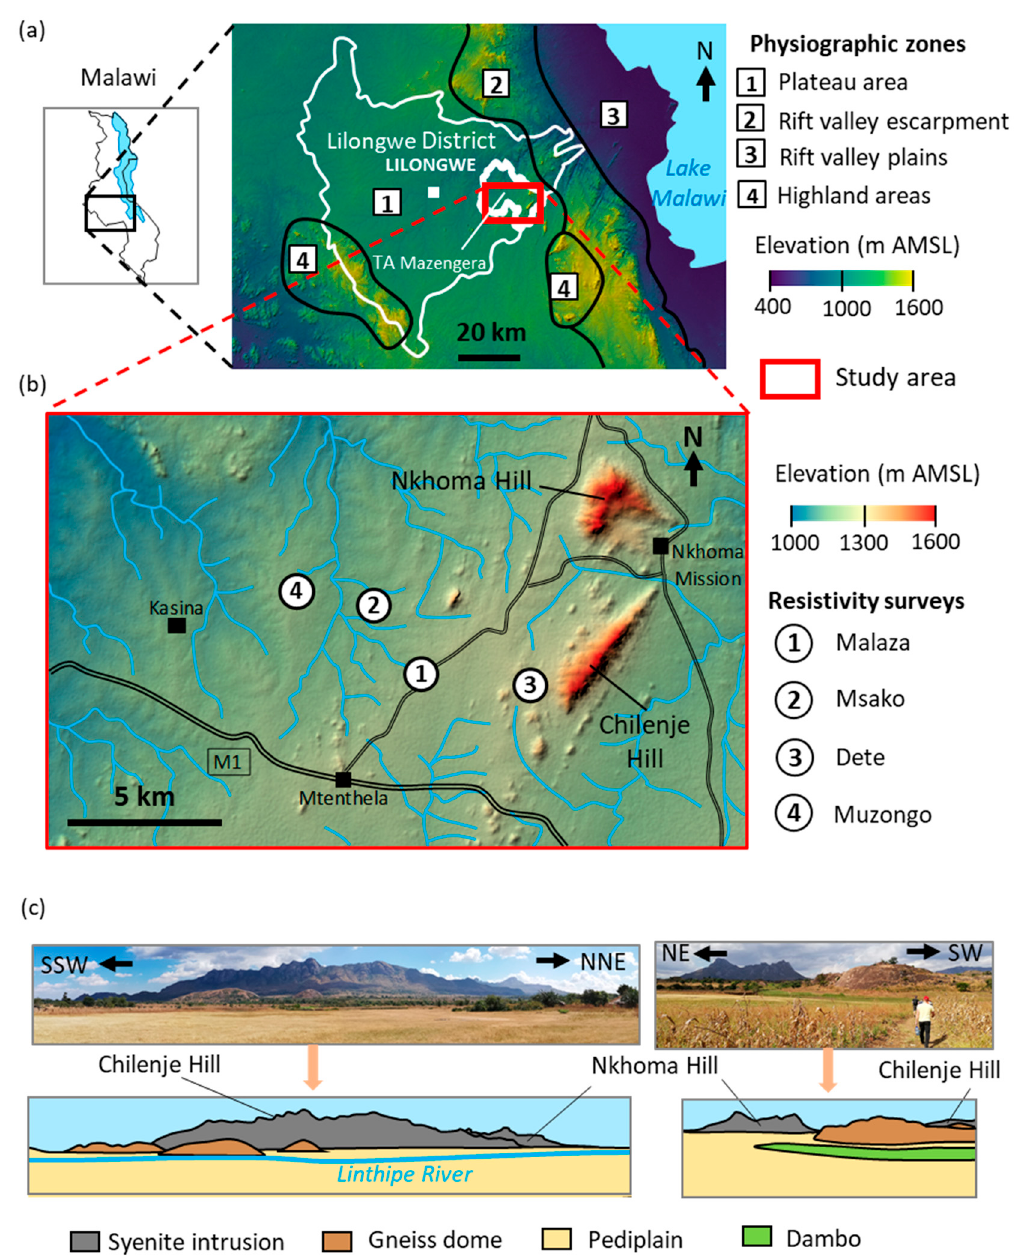
Figure 1. Study area setting: ( a ) surrounding physiographic setting ( b ) location of the four resistivity surveys and ( c ) landscape analyses in the study area. Topographic maps use Shuttle Radar Topography Mission (SRTM) Digital Elevation Model (DEM) data courtesy of NASA (Jet Propulsion Laboratory) and the US Geological Survey and were accessed via the Watkins [65] 30 m grid interface and plotted with QGIS 3.4.4.